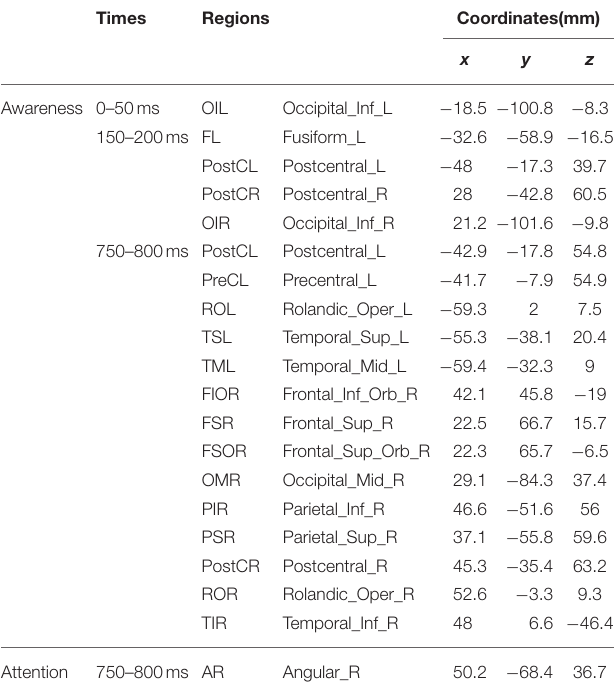
TABLE 1 | MNI coordinates (mm) of the activated